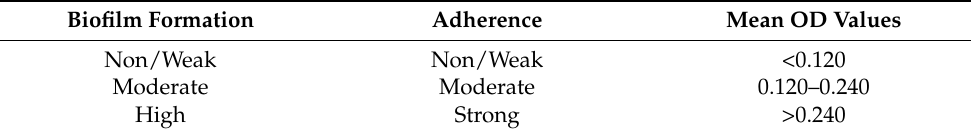
Table 7. Classification of bacterial adherence and biofilm formation by TCP method.